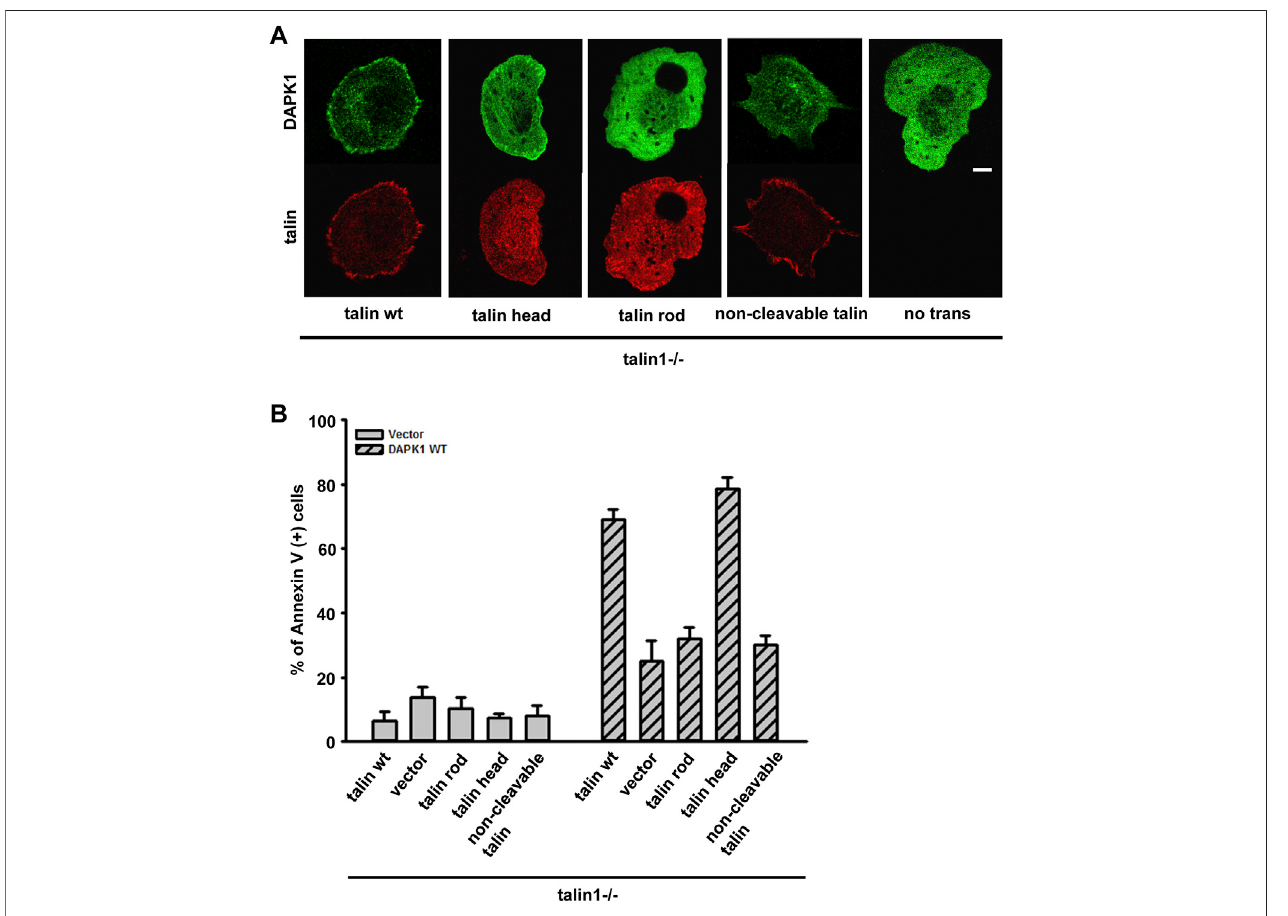
FIGURE 5 | Talin1 head aids in the localization of DAPK1 to the adhesions and facilitates apoptosis. (A) Talin1 − / − cells were co-transfected with DAPK1 and talin1constructs(talin1WT,talin1head,talin1rod,non-cleavabletalin1).Cellswerespreadon fi bronectin-coatedglassdishesfor30 min.Scalebar:10 μ m. (B) Talin1 − / − cells were co-transfected with DAPK1 WT and talin1 constructs (talin1 WT, talin1 head, talin1 rod, NC talin1) for 1 day, followed by anti-Annexin V immunostaining. The percentage of Annexin V positive cells in transfected cells was quanti fi ed. The mean ± SEM of at least two independent experiments is described. For each experiment, 100 – 150 cells were analyzed for each transfection